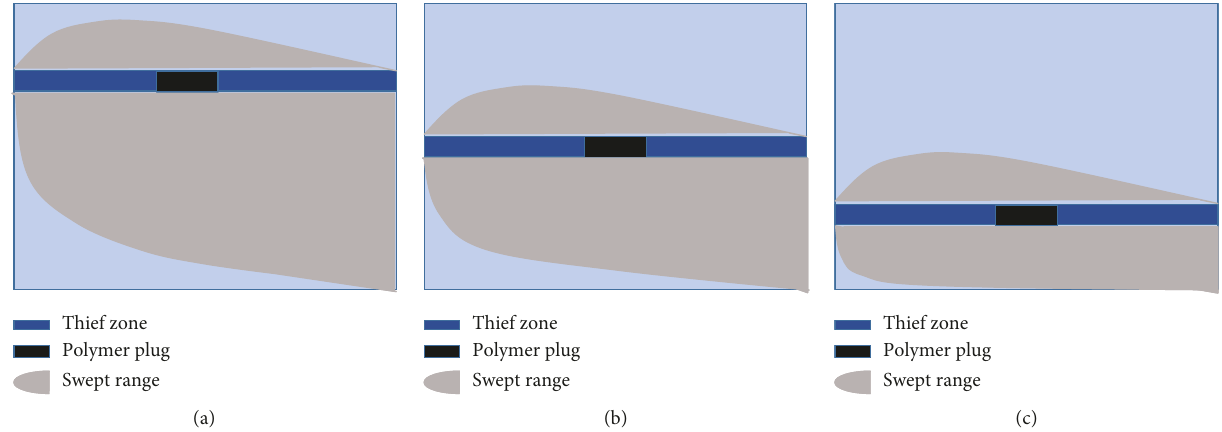
Figure 1: Diagram of the swept range of polymer flooding under different locations of the thief layer. (a) Upper. (b) Middle. (c) Bottom.